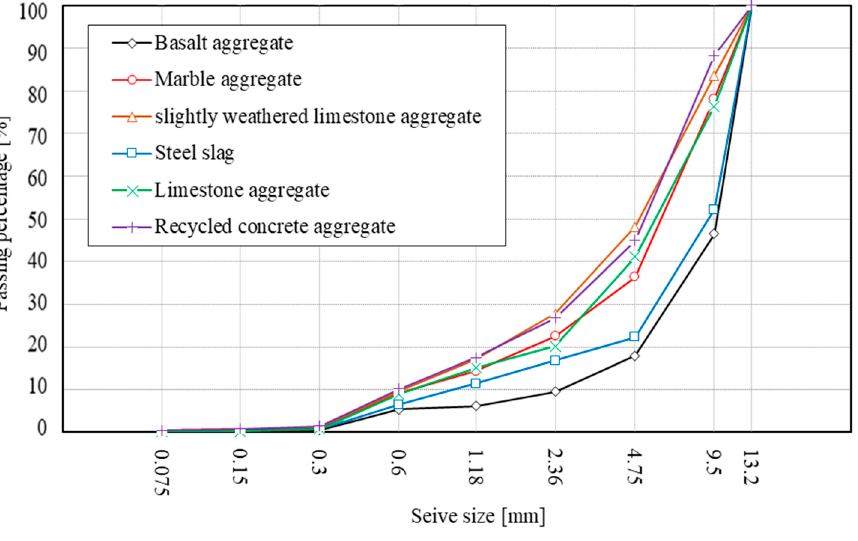
Figure 3. Aggregate grading curves after static ACVTs.